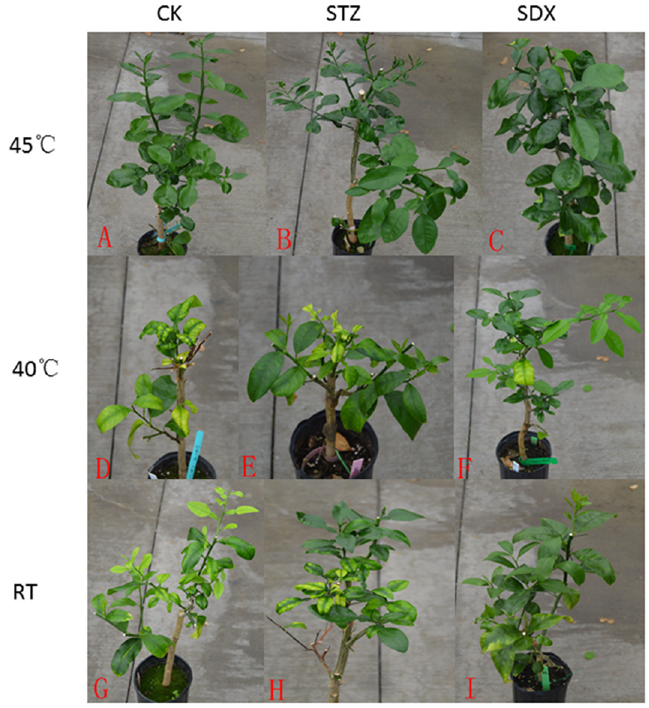
Fig 1. HLB-affected citrus treated with thermo-chemotherapy. A: Thermotherapy at 45°C; B: Combination of thermotherapy at 45°C and chemotherapy with STZ; C: Combination of thermotherapy at 45°C and chemotherapy with SDX; D: Thermotherapy at 40°C; E: Combination of thermotherapy at 40°C and chemotherapy with STZ; F: Combination of thermotherapy at 40°C and chemotherapy with SDX; G: Without thermotherapy and chemotherapy (Kept at room temperature — RT); H: Chemotherapy with STZ at room temperature (RT); I: Chemotherapy with SDX at room temperature